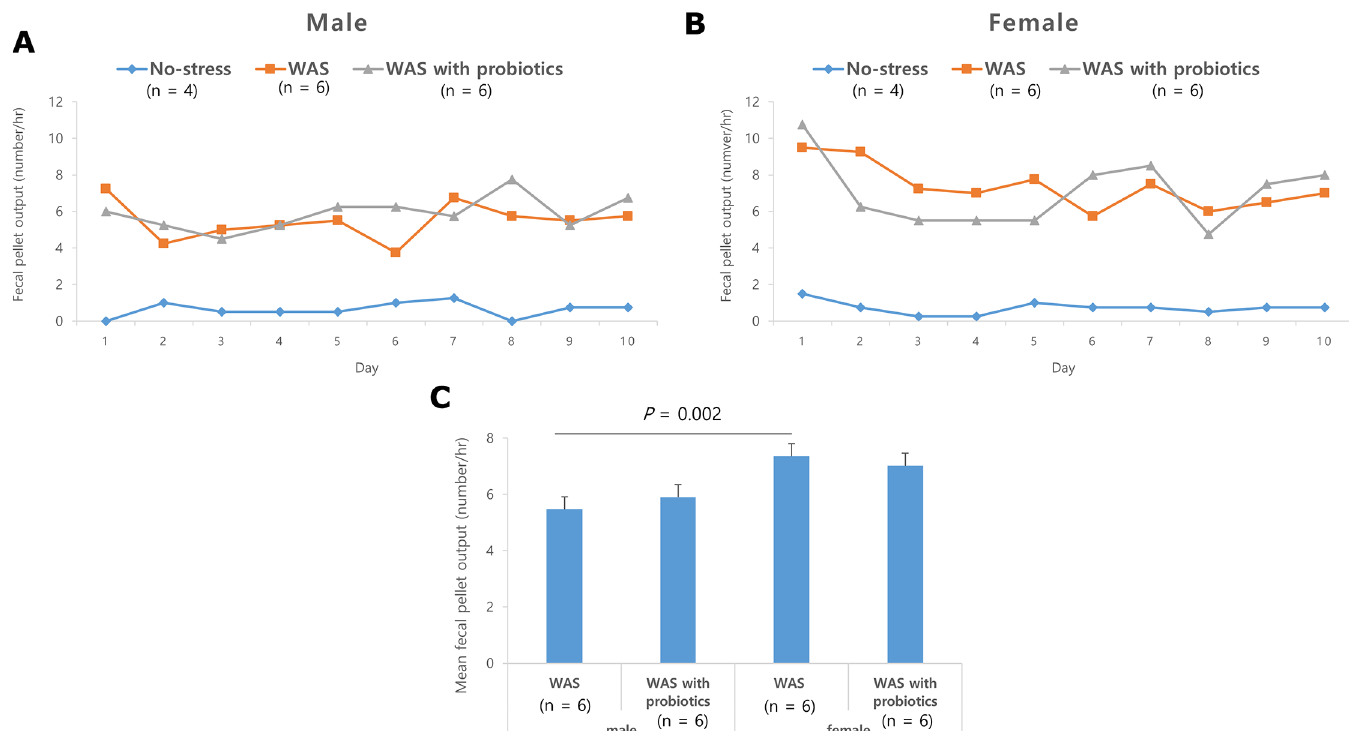
Fig 2. Fecal pellet output (FPO) induced by repeated water avoidance stress(WAS). (A) Daily FPO for 10 days in male with WAS group regardlessof probiotics were significantly higherthan in control.(B) This phenomenawere similar in female.(C) The mean FPO was higheron female WAS group than male WA group ( P = 0.002). Data are expressed as means ±